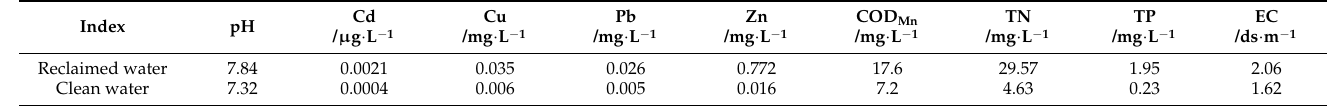
Table 1. Quality index of reclaimed water and tap water.